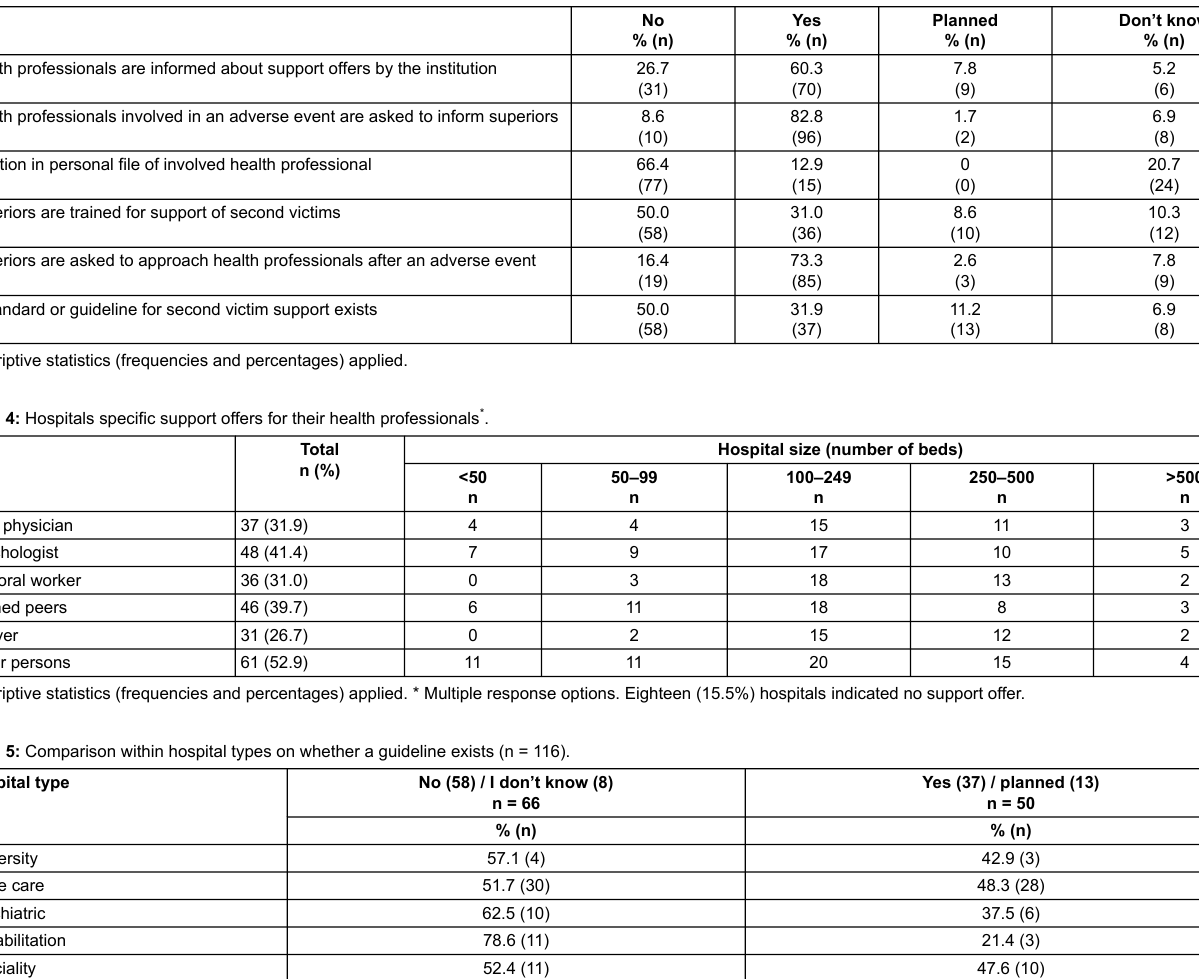
Table 3: Hospitals support for health professionals after an adverse event (n=116).